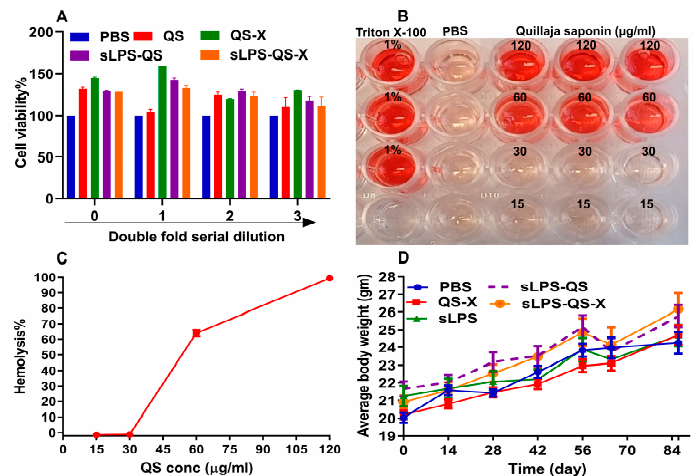
Figure 3. Safety profile of the vaccine components. ( A ) MTT assay showing the impact of different components on the Vero cells 81 viability; 0 represents the highest concentrations (120 µg/mL for QS and 800 µg/mL of xyloglucan) that were two-fold serially diluted through 1 to 3. After dilution, a fixed dose of sLPS (50 µg LPS) was added in the indicated groups. ( B ) Hemolytic effect of different concentrations of Quillaja saponin on mouse RBCs in triplicate; 1% Triton X-100 and PBS were used as positive and negative controls, respectively. ( C ) The optical densities of the free hemoglobin shown in ( B ) were determined and hemolysis percentage of different saponin concentrations was calculated relative to the controls. Data represented as average percentage ± SE (A & C). ( D ) Average body weights of different animals throughout the 86-day study period with no significant changes in body weights. Data represented as average body weight ± SE of sixty mice (D0–D56) and as average body weight ± SE of thirty mice (D65 and